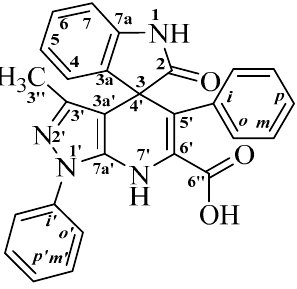
Figure 2. Atom numbering of Spirooxindole 4 . Table 2. C-H correlation with NH-1 and NH-7 ′ protons observed in the HMBC experiment.